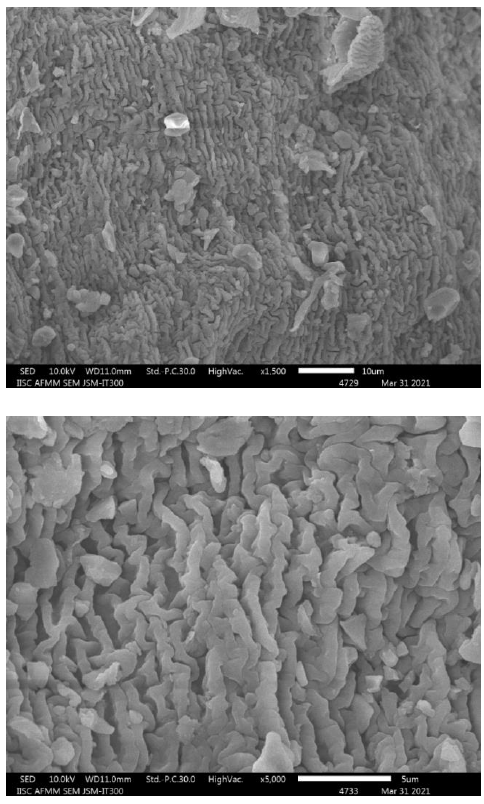
Figure 2. SEM images of RP observed at 1500x (top) and 5000x (bottom) magnification